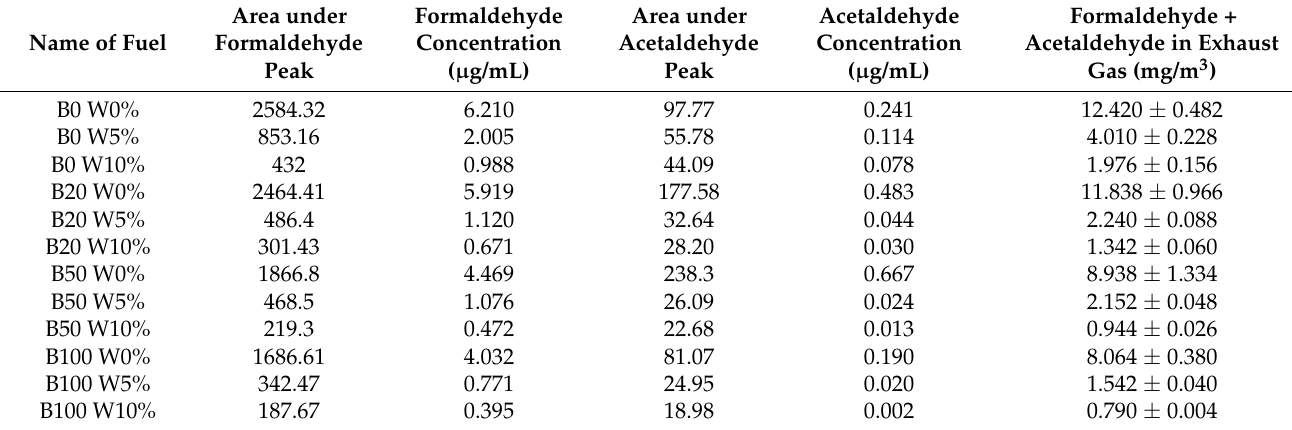
Table 6. Area under the Peaks and Their Corresponding Concentrations for Different